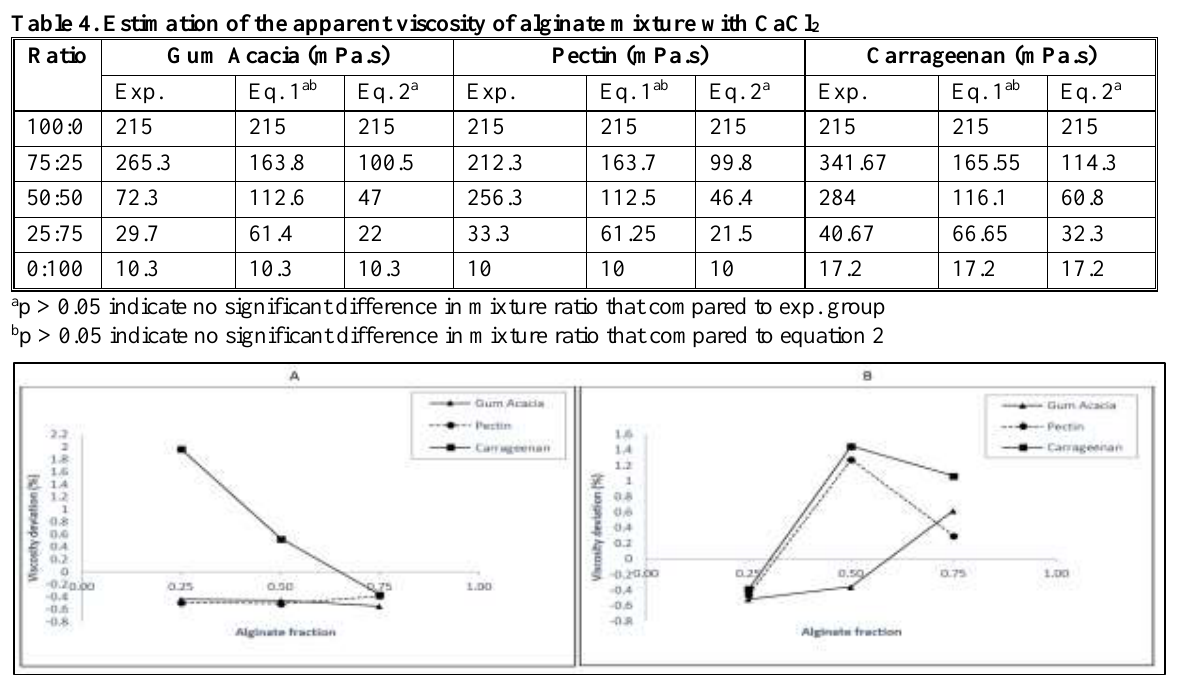
Figure 2. Viscosity deviation of alginate in combination with gum acacia/pectin/carrageenan. (a) in distillate water and (b) in cacl 2 solution.